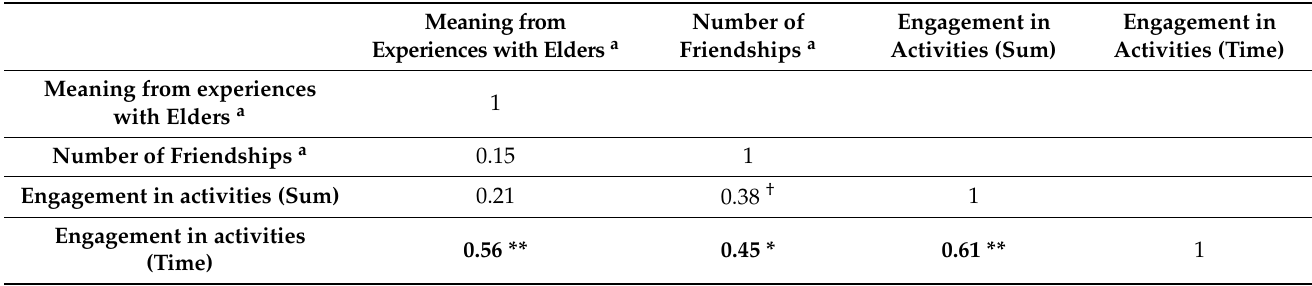
Table 3. Bivariate correlations between meaning, friendships, and engagement variables. Engagement in Engagement in Number of Meaning from Activities (Sum) Activities (Time) Friendships a Experiences with Elders a Meaning from experiences 1 with Elders a Number of Friendships a 0.15 1 Engagement in activities